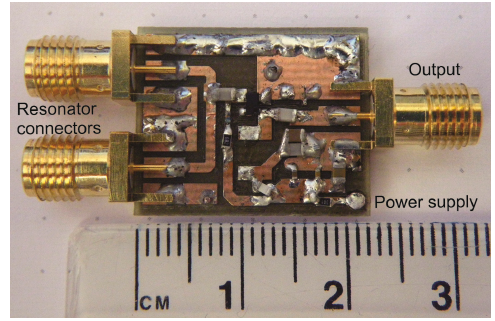
Figure 4. Oscillator prototype.